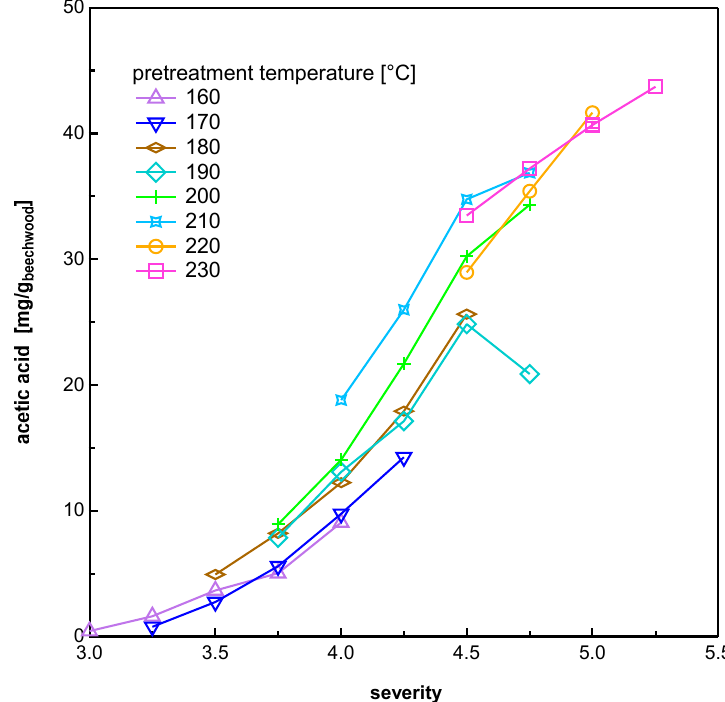
Figure 4. Formation of acetic acid during steam explosion pretreatment. The amount of acetic acid that is released into the prehydrolyzate during steam explosion pretreatment is shown as a function of the pretreatment severity and temperature.